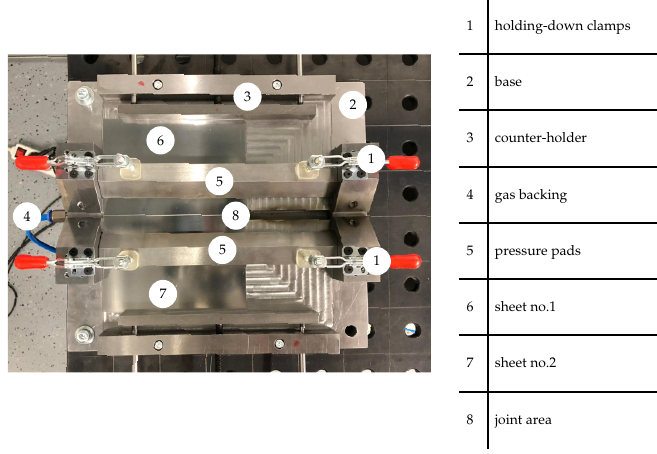
Figure 1. Clamping device used for the welding